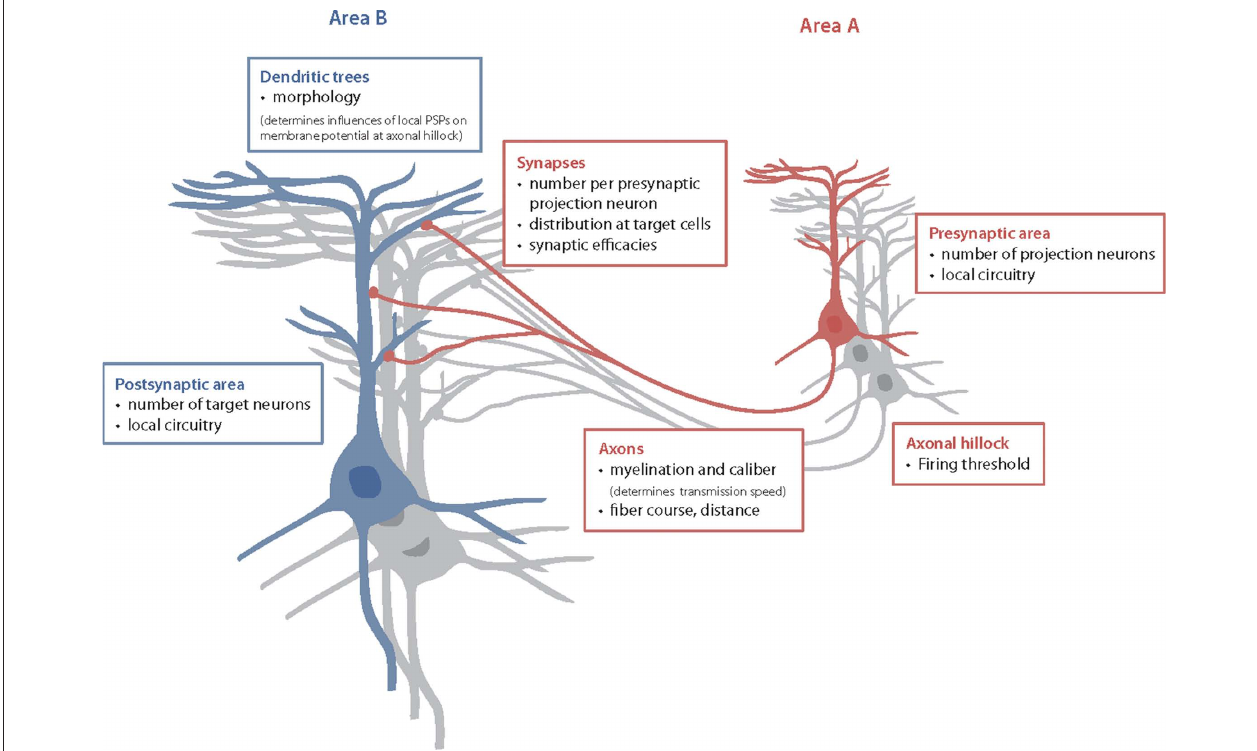
distribution of axonal diameter and myelination of the axons as well as the distance between A and B and the exact course of the fibers – all these factors determine the distribution of transmission speeds; (3) the number of synapses made with cells in area B, their distribution over the target cells and the synaptic efficacies, which depend on numerous factors, including abundance of neurotransmitters and receptors, (4) the number of cells in area B and the local